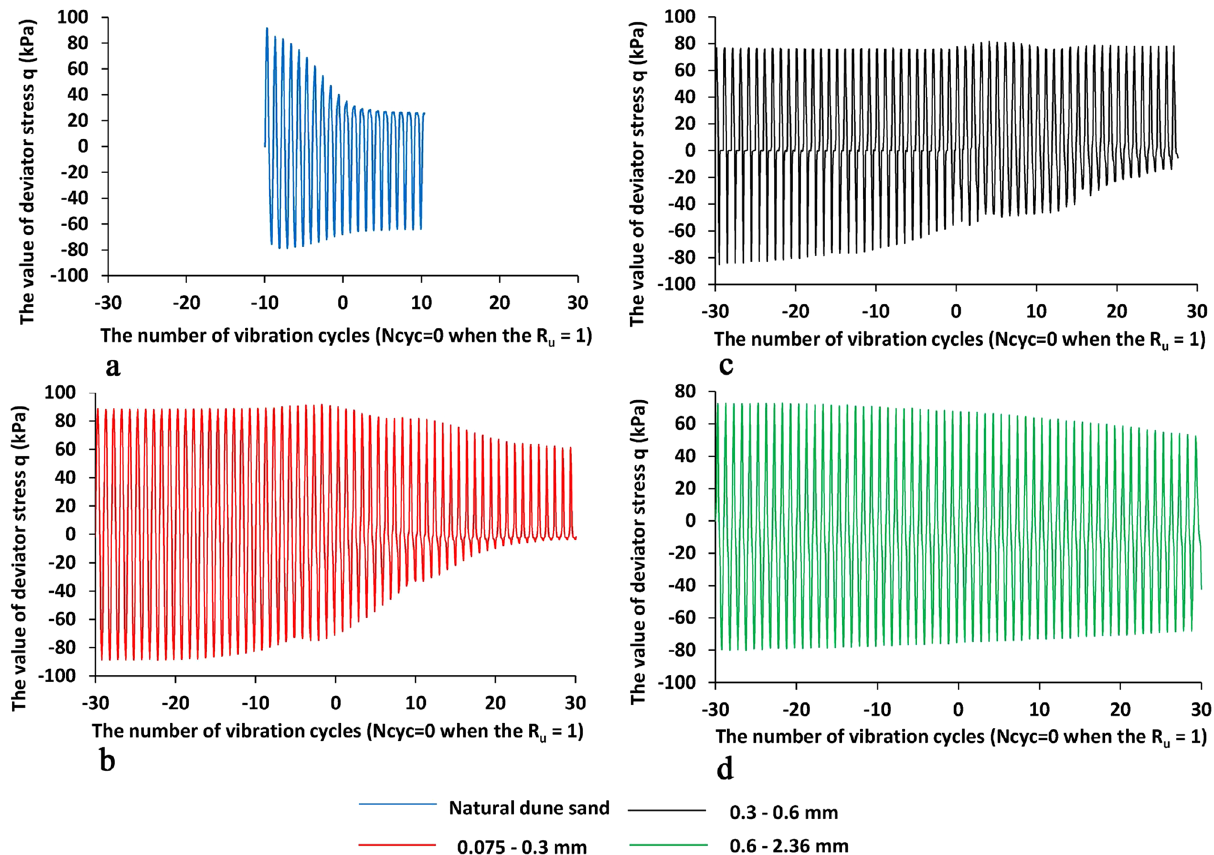
Figure 5. The changes of deviator stress ’q’ vs. vs. the number of vibration cycles N cyc for four sand samples under study, the X-values is the number of vibration cycles while 0 when the R u is reached to 1—Fig. 4 (the negative value of N cyc means the state before the liquefaction point while the positive values after the liquefaction point), the Y-axis is the value of deviator stress q (kPa). The blue, green, black, and red lines are for natural dune sand, fractions 2.36–0.6, 0.6–0.3, 0.3–0.075 mm,